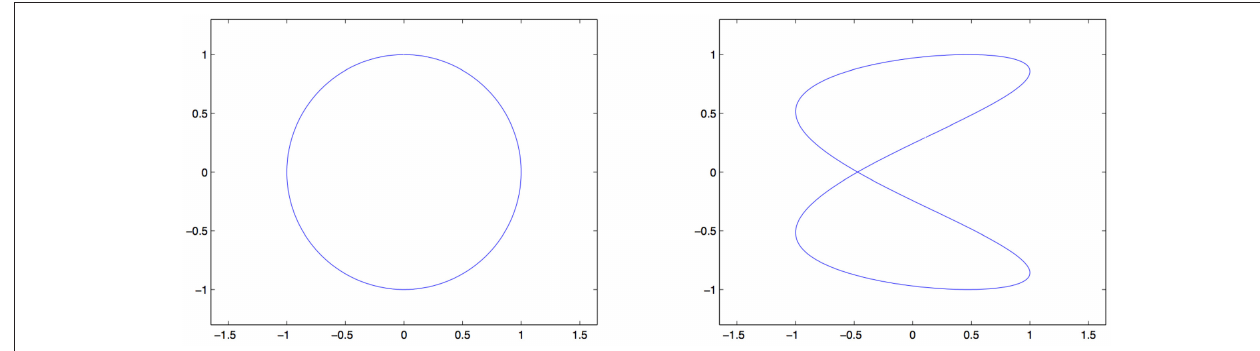
FIGURE 3 | From left to right, top to bottom. The set ˆ C m , τ n with n , respectively 2,3,4,5, m